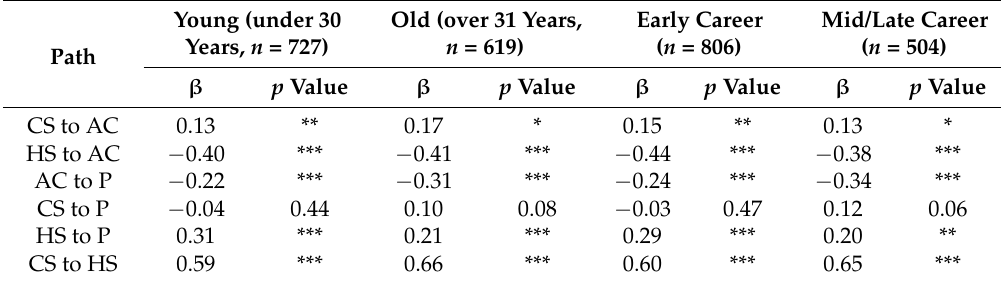
Figure 2. Final model illustrating how challenge stress and hindrance stress influence affective commitment and presenteeism (numbers not in bold are standardized regression coefficients and numbers in bold explain variability; chi square, 773.373; degrees of freedom, 0.99, p < 0.001; root mean square error of approximation, 0.068; goodness-of-fit index, 0.935; normed fit index, 0.951; comparative fit index, 0.945; *** p < 0.001). Table 4. Standardized regression coefficients ( β ) with p values for the components of subgroup analyses.